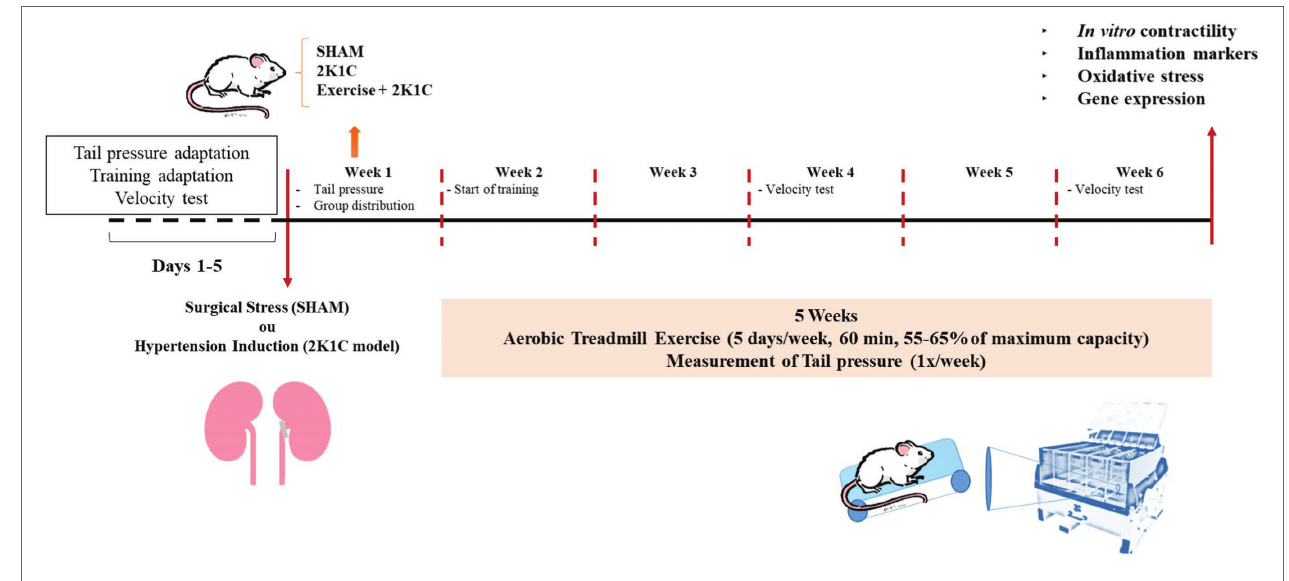
FIGURE 1 | Experimental